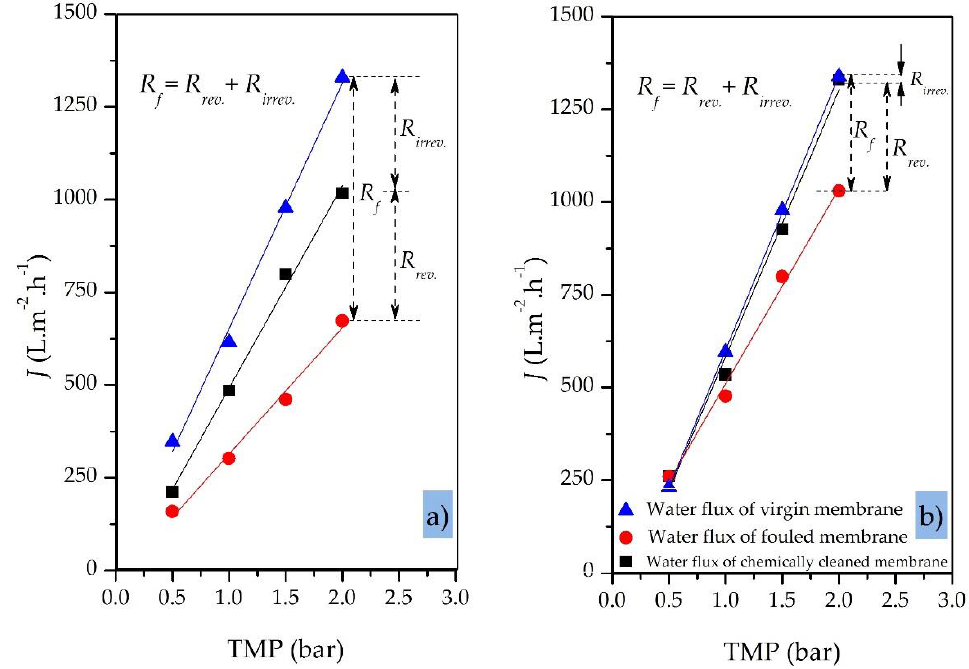
Figure 10. Pure water flux for a 200 nm SiC MF membrane (virgin, fouled and cleaned) against transmembrane pressure. ( a ) Variable TMP (0.5–2.0 bar); CFV = 1.0 m · s − 1 ; C oil of oily model transmembrane pressure. ( a ) Variable TMP (0.5 – 2.0 bar); CFV = 1.0 m·s −1 ; C oil of oily model solution = solution = 100 ppm; T = 40 ◦ C; total recycle mode. ( b ) Constant TMP = 1.0 bar; other parameters 100 ppm; T = 40 °C; total recycle mode. ( b ) Constant TMP = 1.0 bar; other parameters as above. as